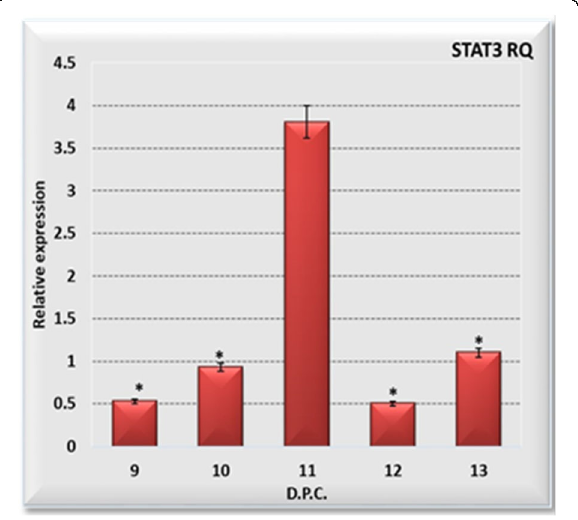
Fig. 4 Histogram representing the gene expression of signal transducer and activator of transcription 3 (STAT3), at the embryonic stages E9.5 to E13.5 of rat embryos ( Rattus norvegicus ).* means significant against 11 D.P.C. group. P <